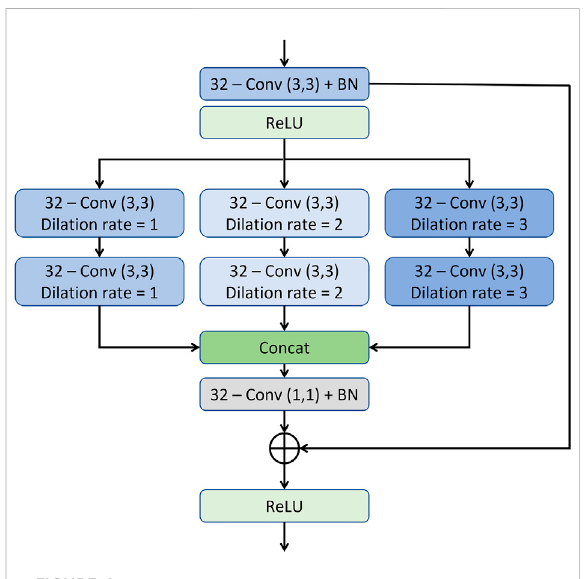
FIGURE 4 The architecture of the multi-resolution convolution block.